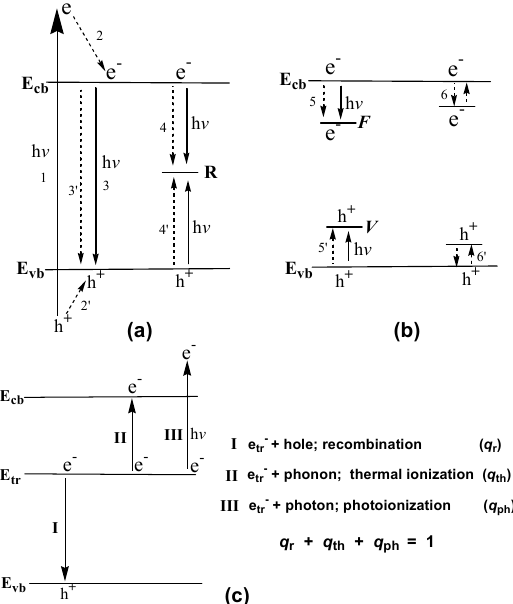
Figure 14. Schemes illustrating the processes of: recombination ( a ); and trapping ( b ) of photocarriers and events leading to discharge of the defect (for distinctness for defect with captured electron): Step 1: band-to-band optical transition with “hot” electron and “hot” hole generation, where the corresponding initial levels of excited electron and hole lay above the “bottom” of conduction band (E c ) and below the “selling” of the valence band (E v ); Steps 2 and 2 (cid:48) : thermal relaxation of hot carriers; Steps 3 and 3 (cid:48) : radiative and nonradiative band-to-band recombination; Steps 4 and 4 (cid:48) : radiative and nonradiative recombination via defects; Steps 5 and 5’: trapping of carriers with formation of color centers; and Steps 6 and 6 (cid:48) : trapping and de-trapping of carriers by shallow traps (for further details, see text). ( c ) various stages I, II, and III regarding recombination, thermal ipomnization and photoionization, respectively. Adapted from Artemiev and Ryabchuk